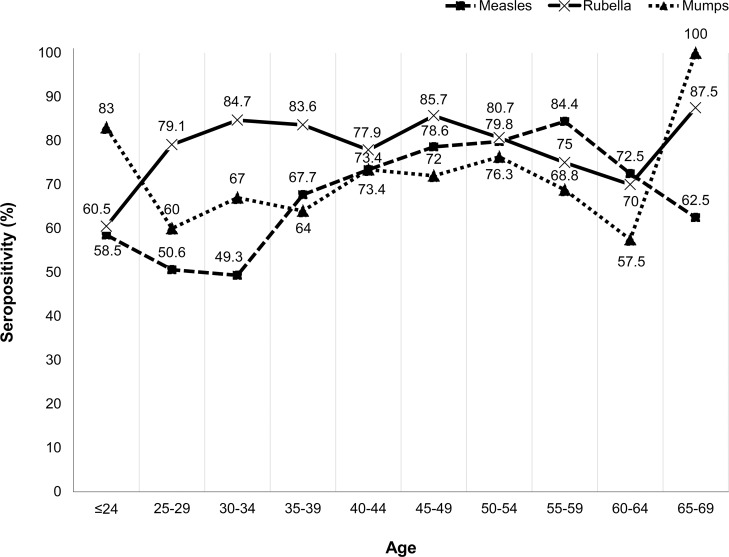
Seropositivity ratio by age groups (females).